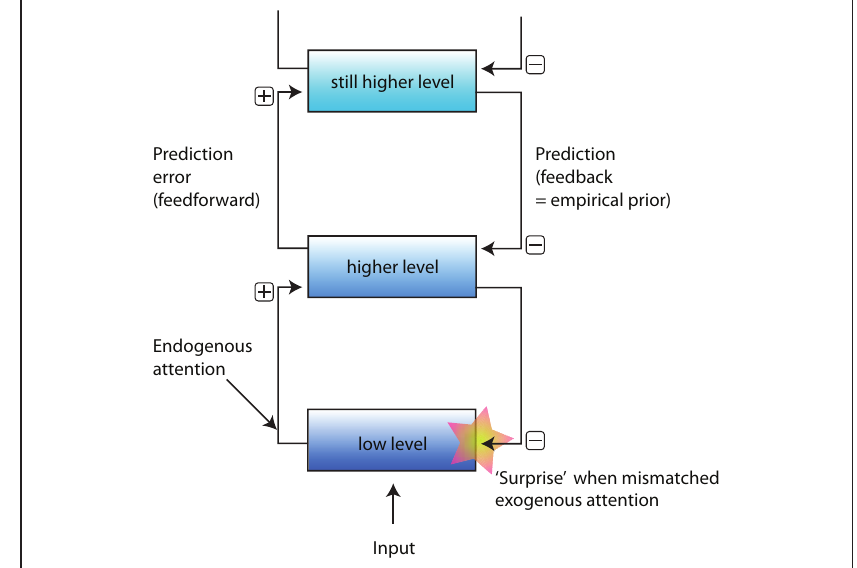
FIGURE 1 | A schematic representation of the predictive coding framework. Input arrives from the sensory organs, and is processed in a “low-level” area. This processed information is sent to a higher area. Based on this input the higher area tries to explain, and predict the sensory data, and feeds back a prediction. The prediction is more or less equivalent to the “prior” in the Bayesian framework. The prediction is subtracted from the activity at the lower level, and the residual is the “prediction error.” The prediction error may be equivalent to “exogenous attention.” Finally, endogenous attention may influence the feedforward